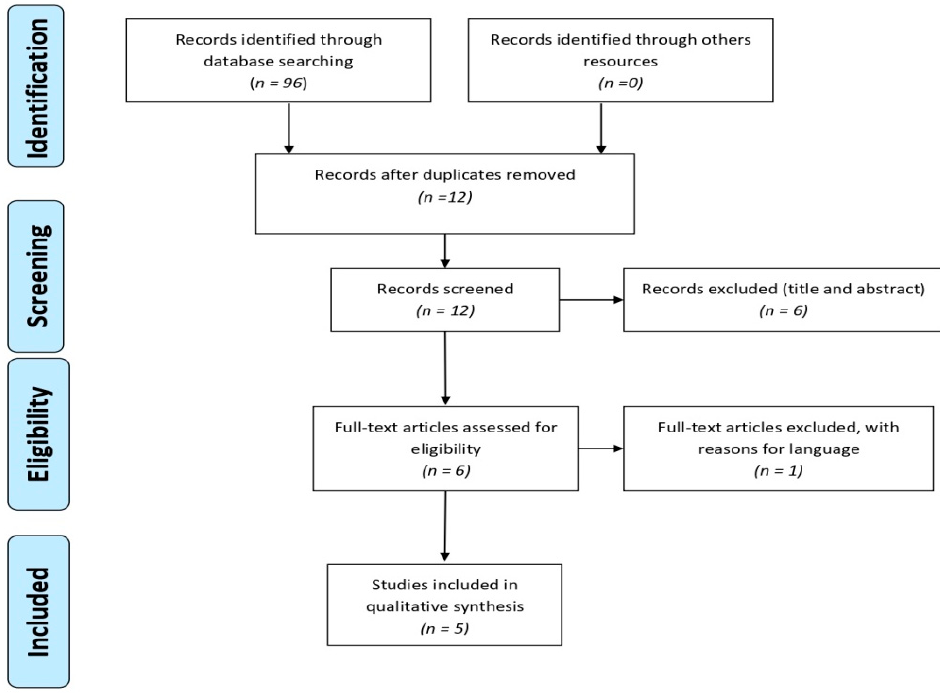
Figure 1. PRISMA flowchart [16].